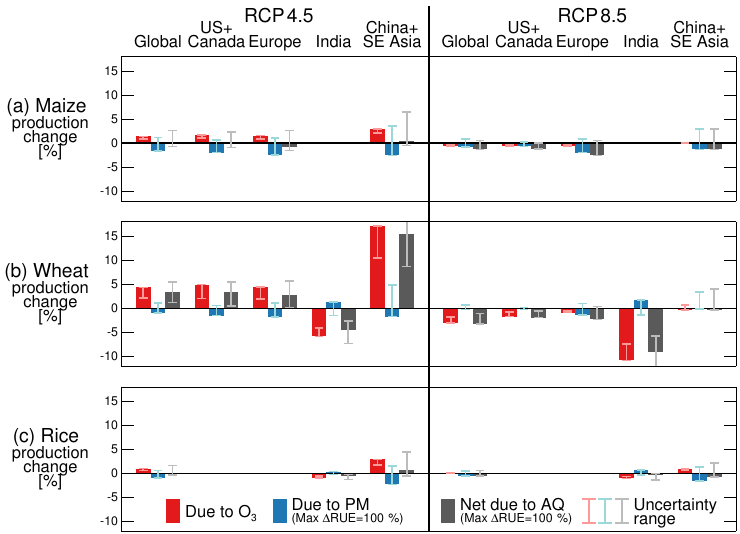
Figure 8. For both RCP4.5 (left) and RCP8.5 (right) emissions scenarios: regional relative change in crop production due to surface ozone (red bars), PM with max (cid:49) RUE = 100% (blue bars), and both ozone and PM (gray bars). Change from 2010 to 2050 for (a) maize, (b) wheat, and (c) rice. Light red, light blue, and light gray lines are as in Fig. 7. Regions with a base production lower than 5% of the global total are not shown. Relative change calculated from GAEZ 2010 base